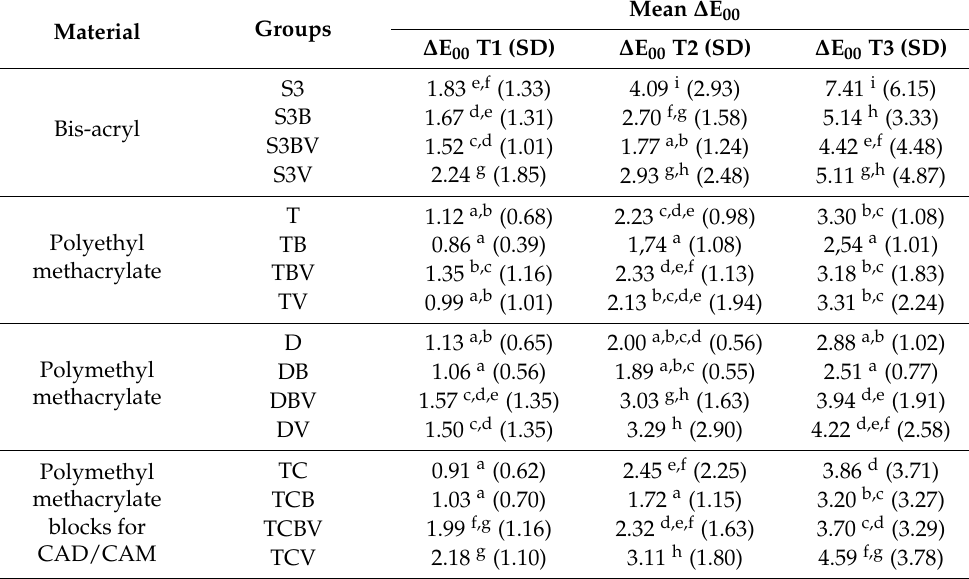
Table 4. Mean of color stability ( ∆ E 00 ) for each group immersed in different staining solutions according to the time (Equation